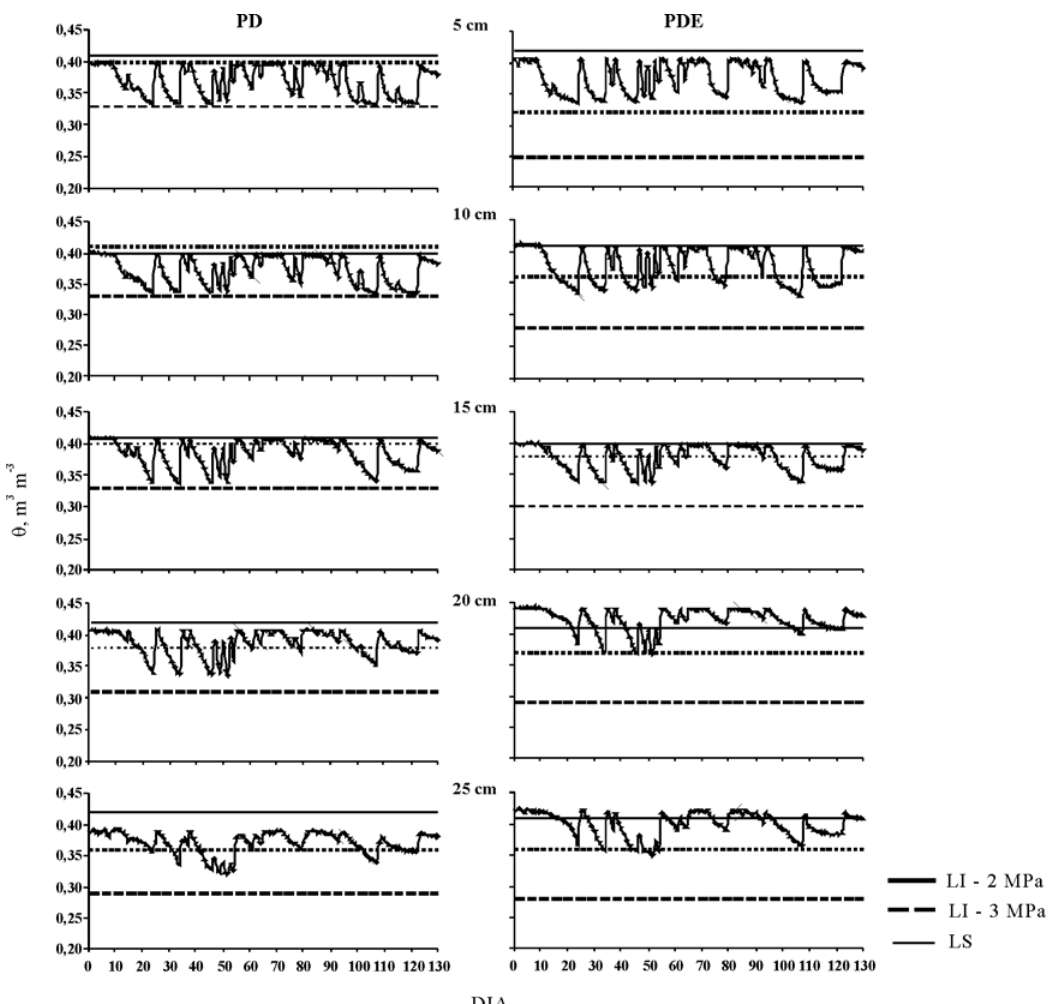
Figura 4. Variação temporal da umidade do solo com limites do